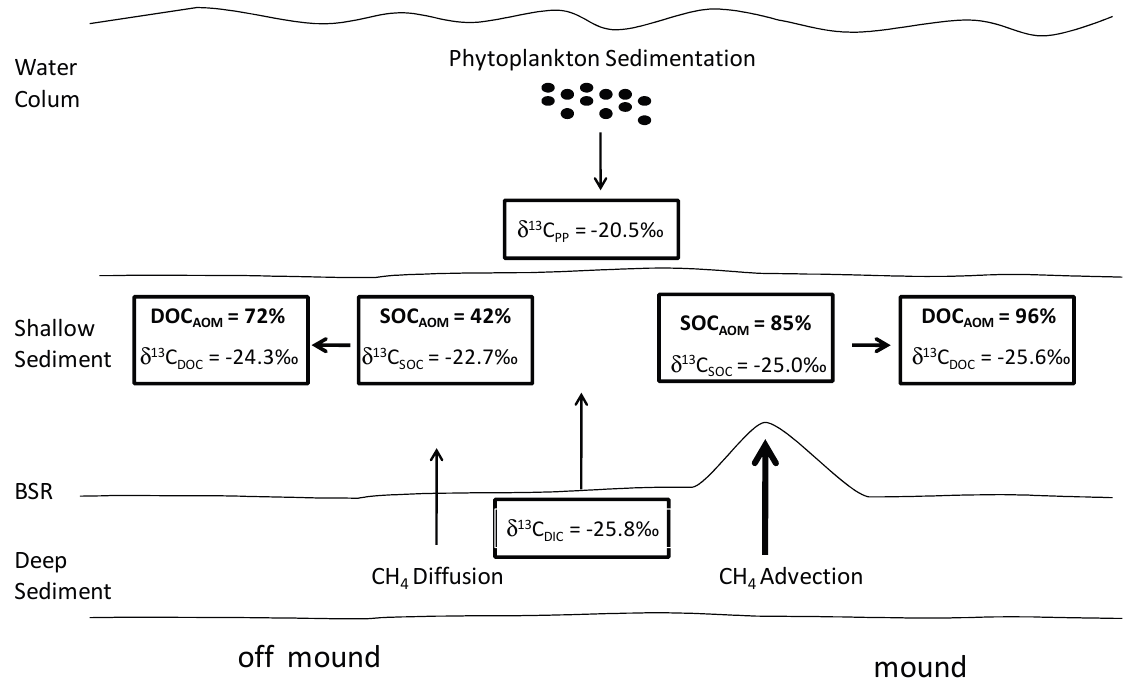
Figure 8. A summary of dissolved organic carbon (DIC) and phytoplankton biomass contributions to shallow SOC and DOC at the on-mound and off-mound sites using δ 13 C